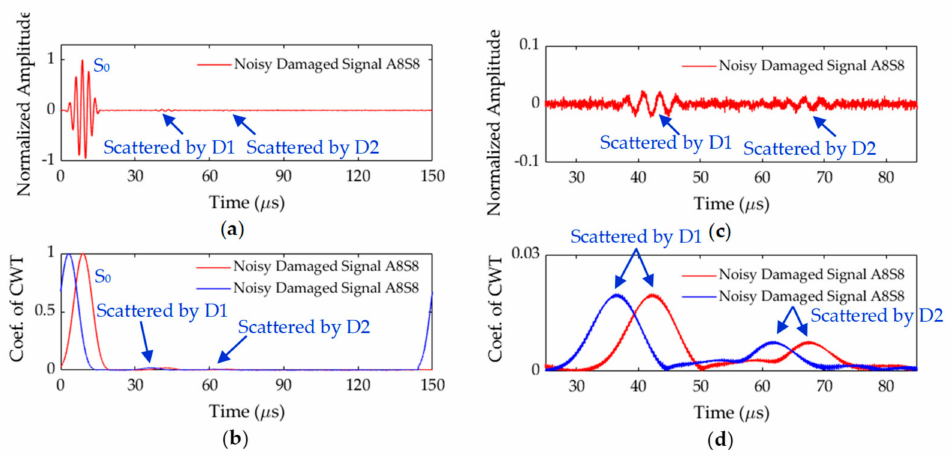
Figure 24. ( a ) Damaged signal at A8B8 with signal-to-noise ratio (SNR) 30 dB; ( b ) coe ffi cient of CWT with (blue) and without (red) time compensation A8B8 with SNR 30 dB; ( c ) damage-focused region of signal ( a ); ( d ) damage-focused region of signal ( b